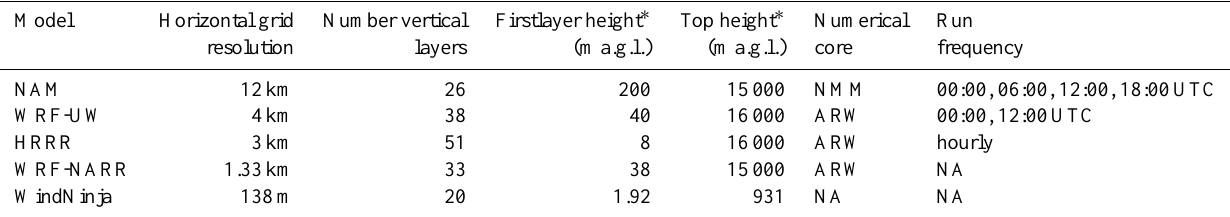
Table 1. Model specifications.